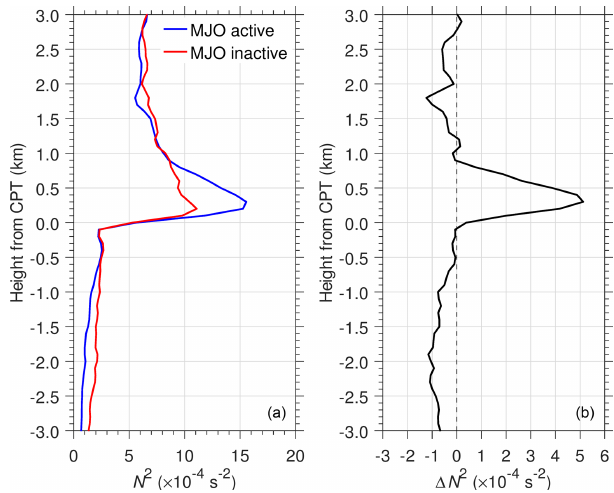
Figure 12. Time–longitude distribution (Hovmöller diagram) of S - ab ∗ (color shading) and OLR ∗ (dotted contours). Color contour in- terval is 0 . 25 × 10 − 4 s − 2 and only negative values of OLR ∗ are shown for − 35, − 25, − 15, − 5, and − 2 . 5Wm − 2 .